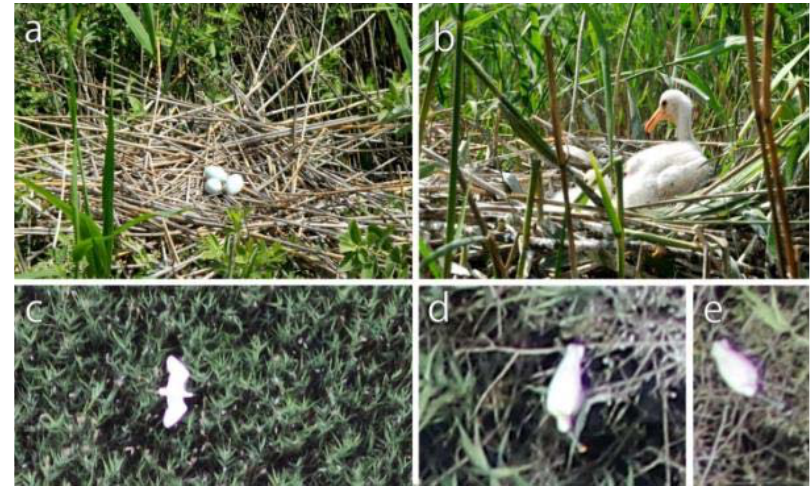
Figure 3. The Eurasian Spoonbill’s ( a ) eggs, ( b ) nestling, and the Eurasian Spoonbill in a ( c ) flying and in ( d , e ) sitting position. (capture by Örs Ábrám, Edina Morvai and Gábor Bakó). The widening part of the Eurasian Spoonbill’s beak is occasionally yellow on the orthophotos, but not in all cases. On top of its back, a yellow spot can often be observed.